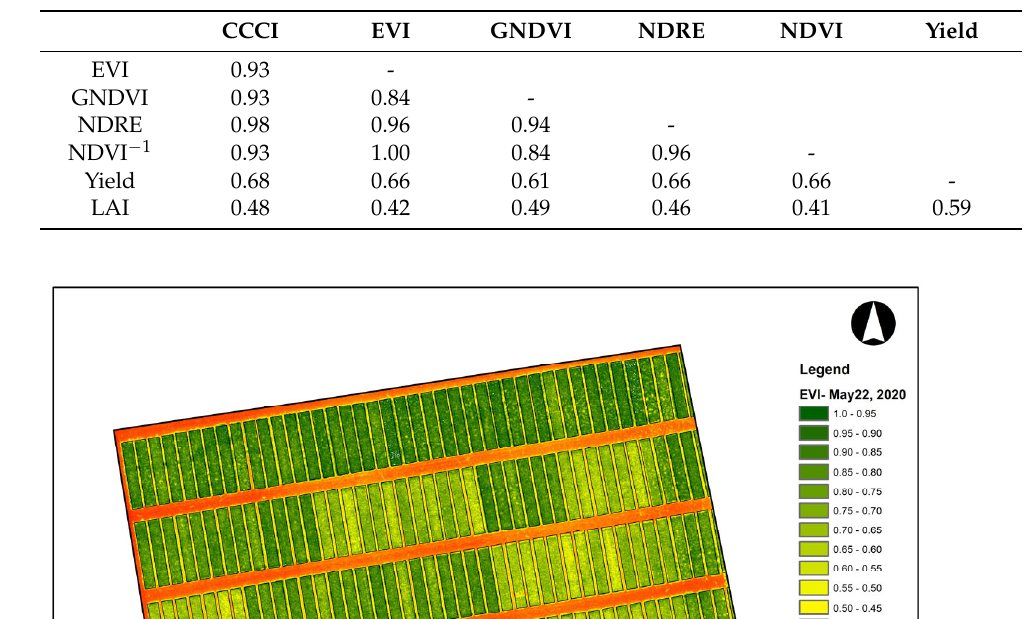
Table 9. Simple correlation coefficients between selected vegetation indices and the yield of hypoal- lergenic wheat grain (22 May 2020).